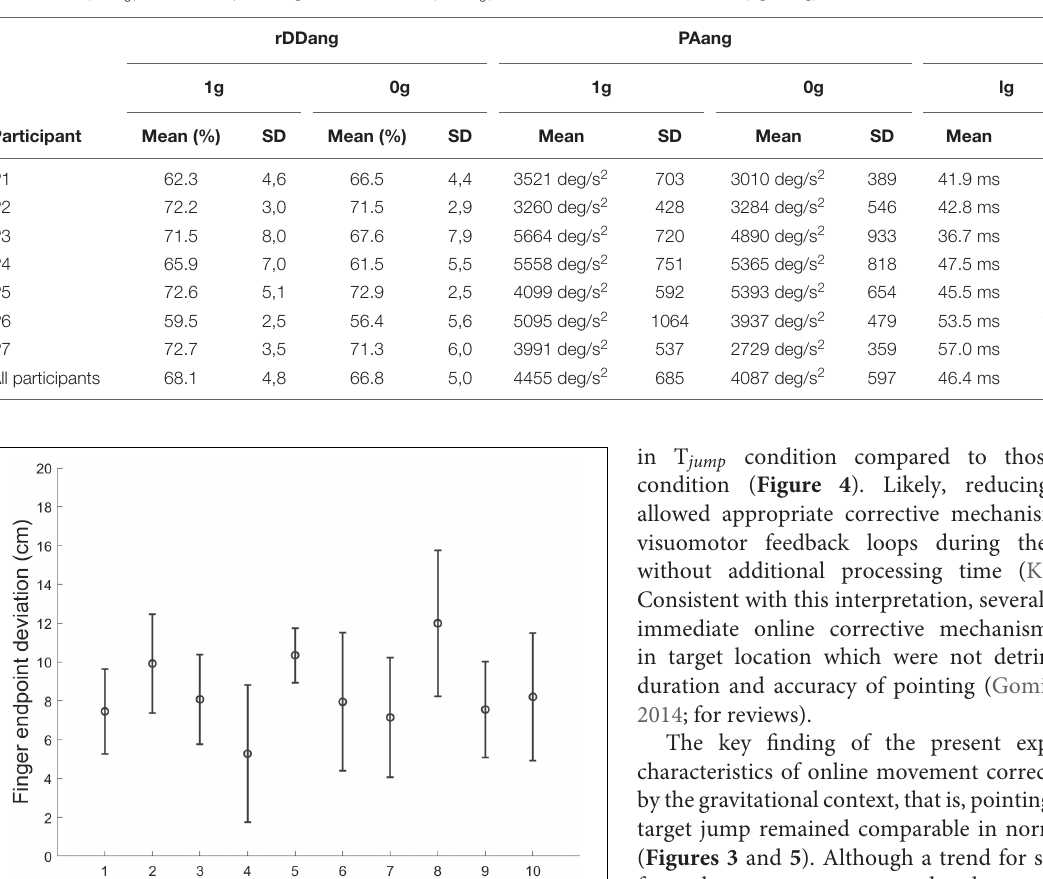
TABLE 1 | Mean individual values and intrasbject standard deviation (SD) for the angular deceleration duration relative to movement time (rDD ang ), the peak angular acceleration (PA ang ) and time to peak angular deceleration (TPA ang ) as a function of the environment (1g vs 0g).